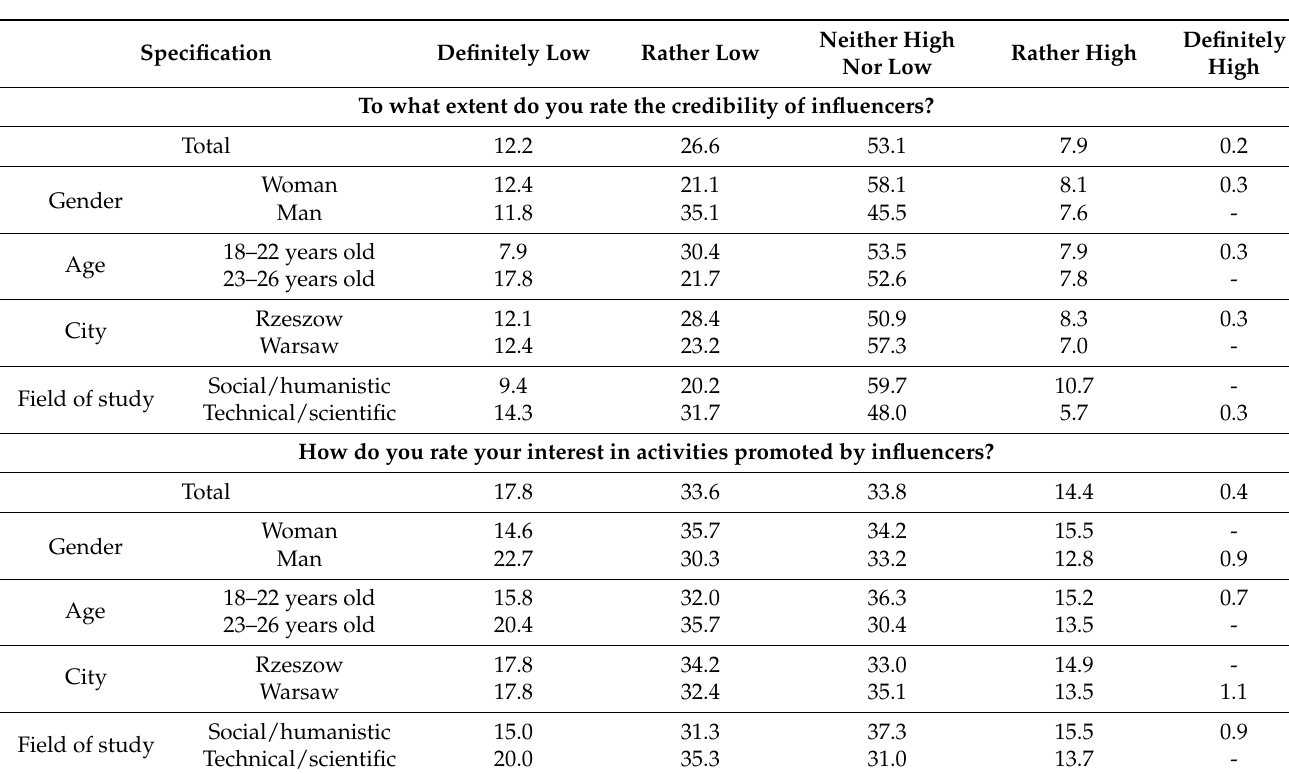
Table 5. An assessment of the impact of influencers on social media on the behavior of Generation Z